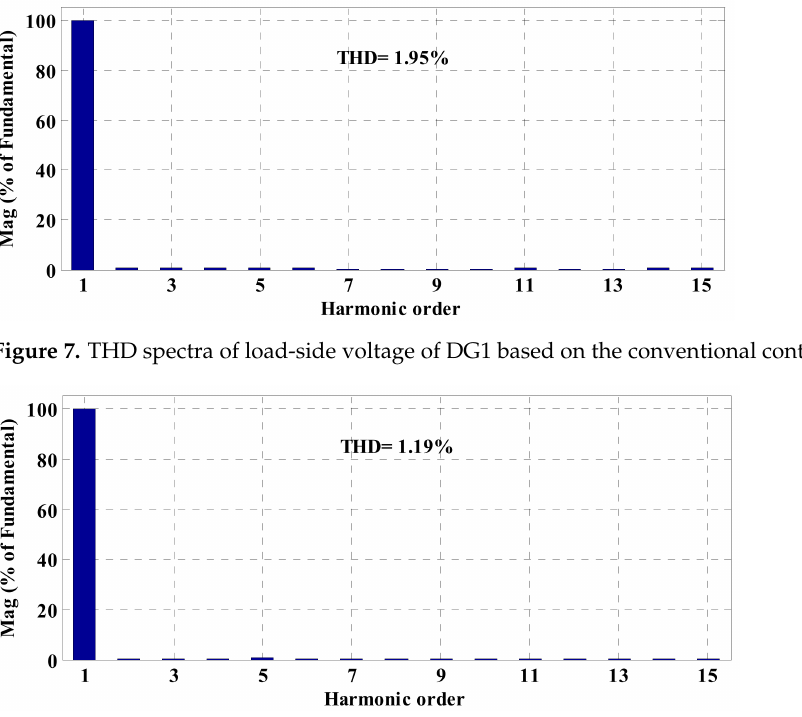
Figure 8. THD spectra of load-side voltage of DG1 based on the proposed control